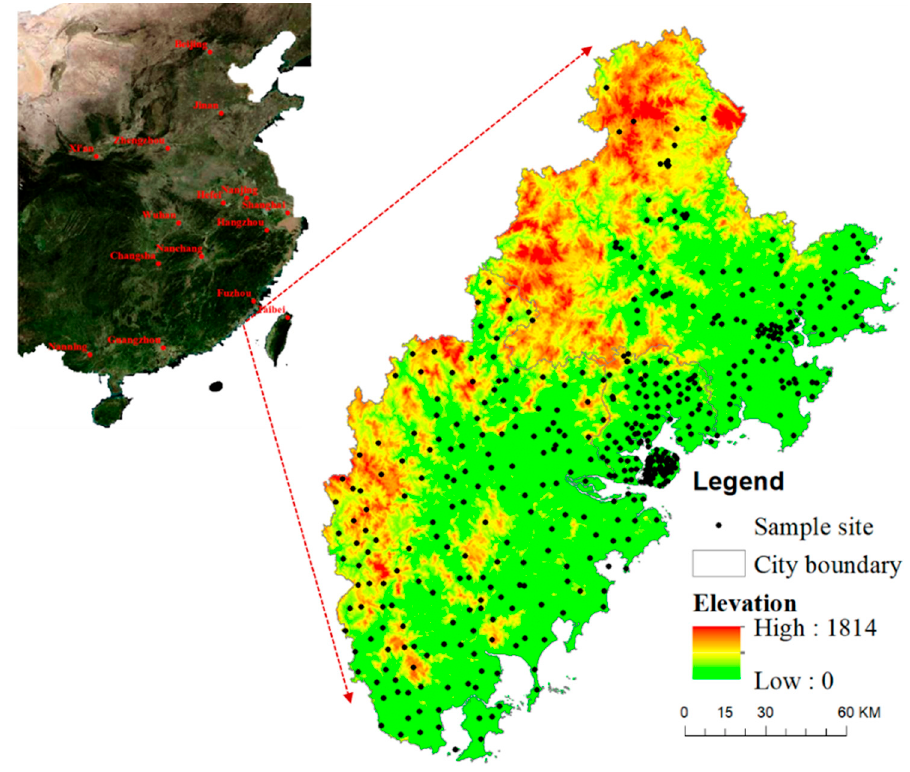
Figure 1. Distribution of sampling sites in the Golden Triangle of Southern Fujian Province.